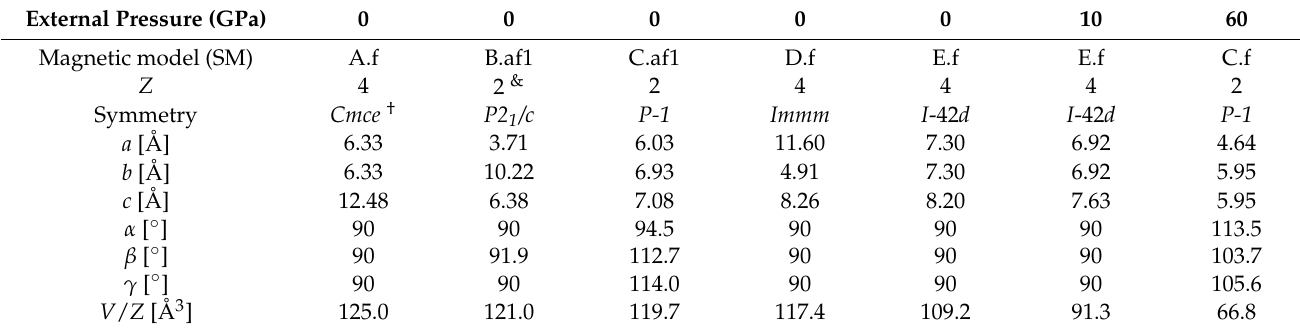
Table 1. Crystallographic data regarding ambient-pressure and high-pressure polymorphs of K 2 AgF 4 as derived from DFT computations. The .cif files are provided in the Supplementary Materials.